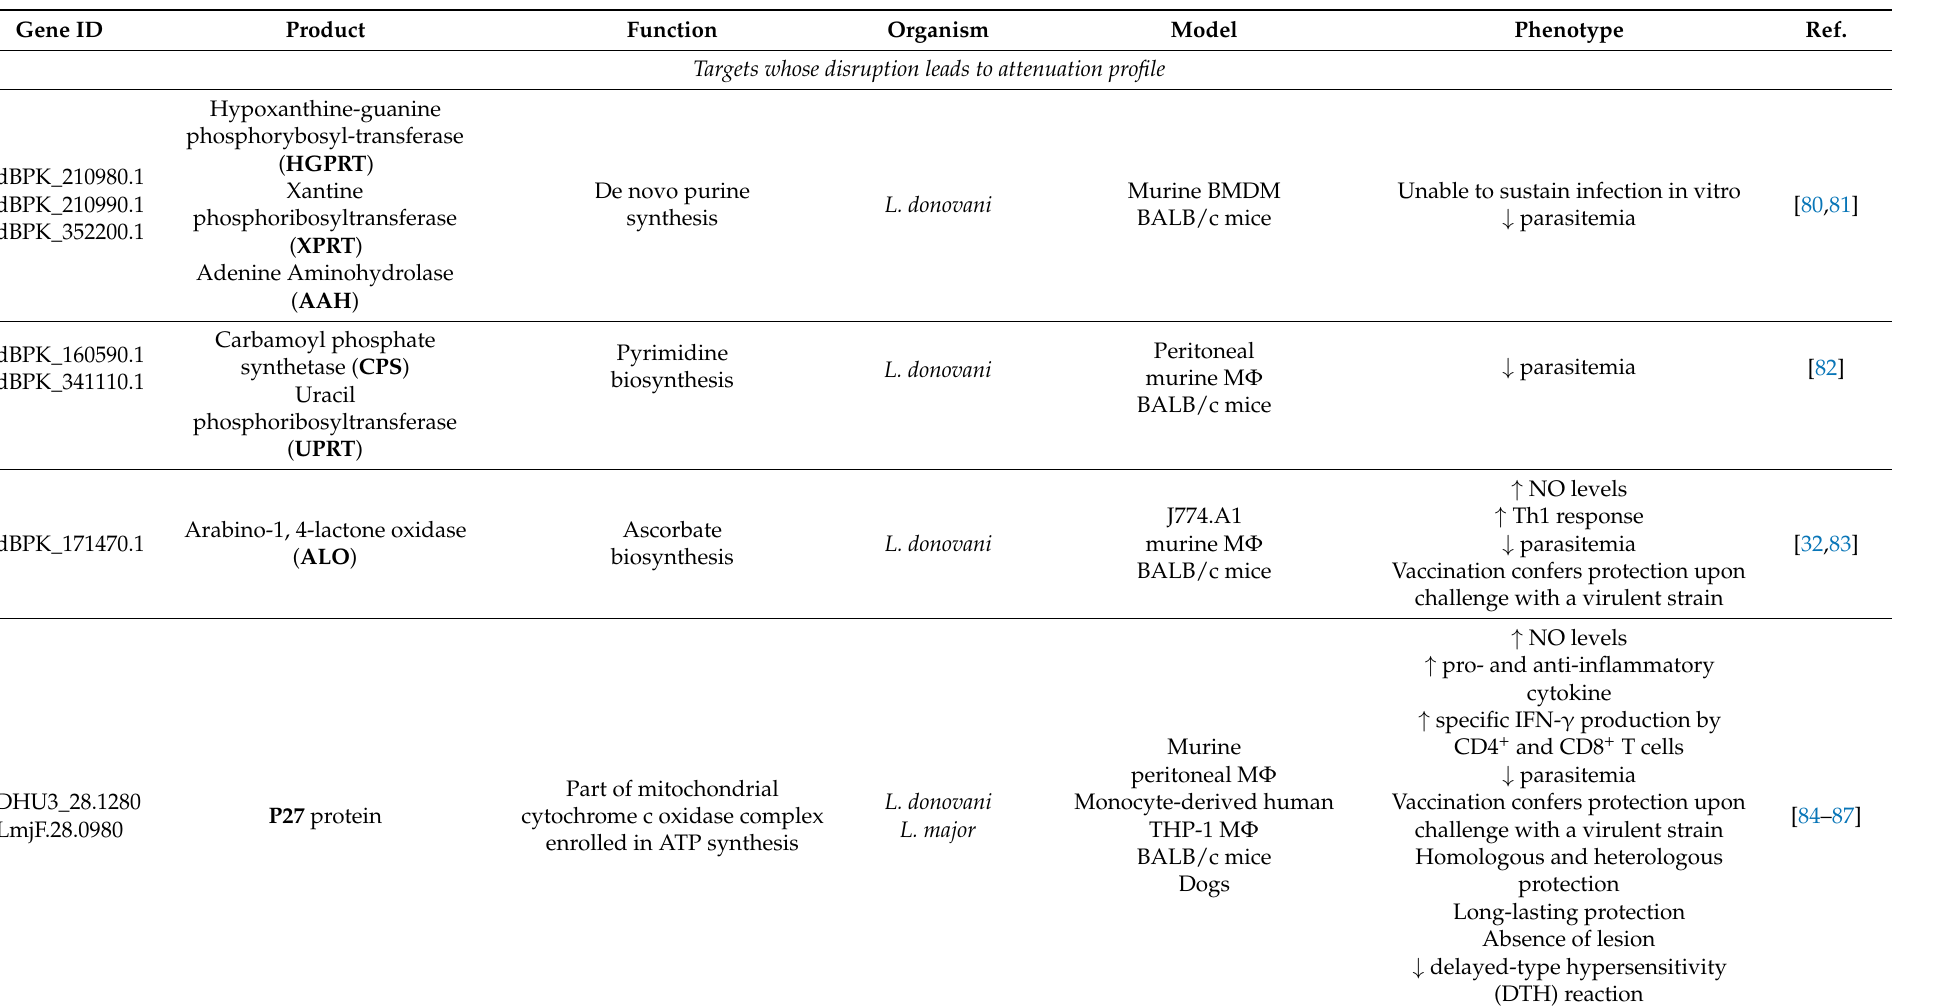
Table 1. Genetically modified Leishmania parasites where gene editing leads to attenuation. The function or metabolic pathway associated with each gene target is presented together with the Leishmania species, experimental model used and the resulting phenotype (in vitro and in